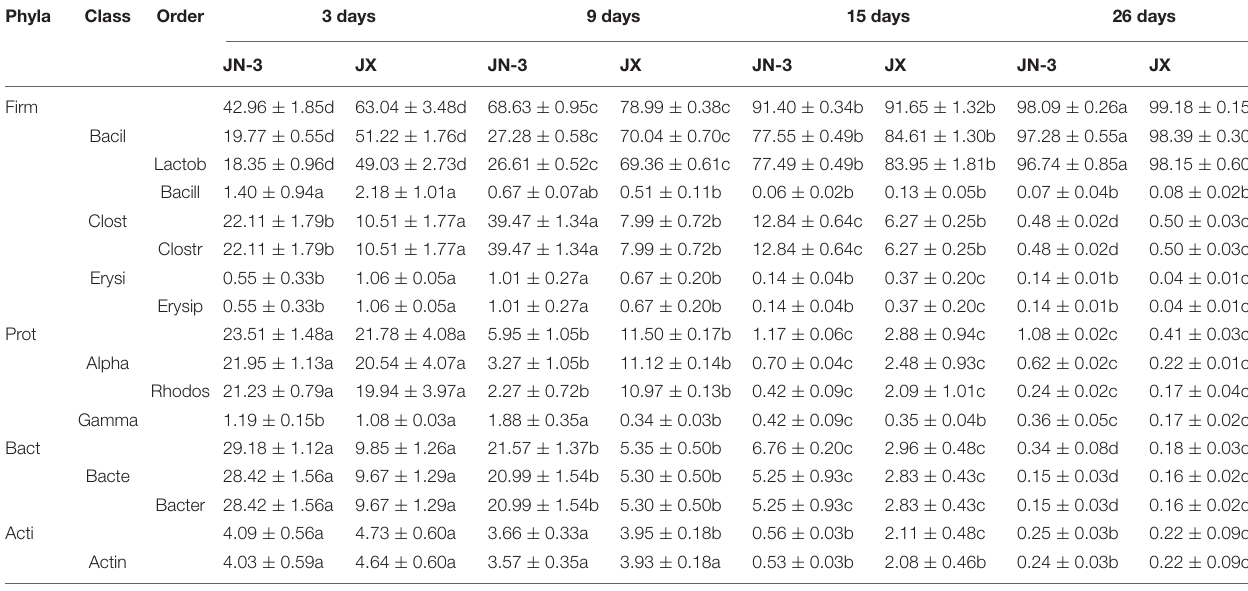
TABLE 1 | Relative abundances (average values and standard error) of bacterial compositions across taxonomical classification (phyla, class, and order) of fermented grains in waxy and non-waxy sorghum during